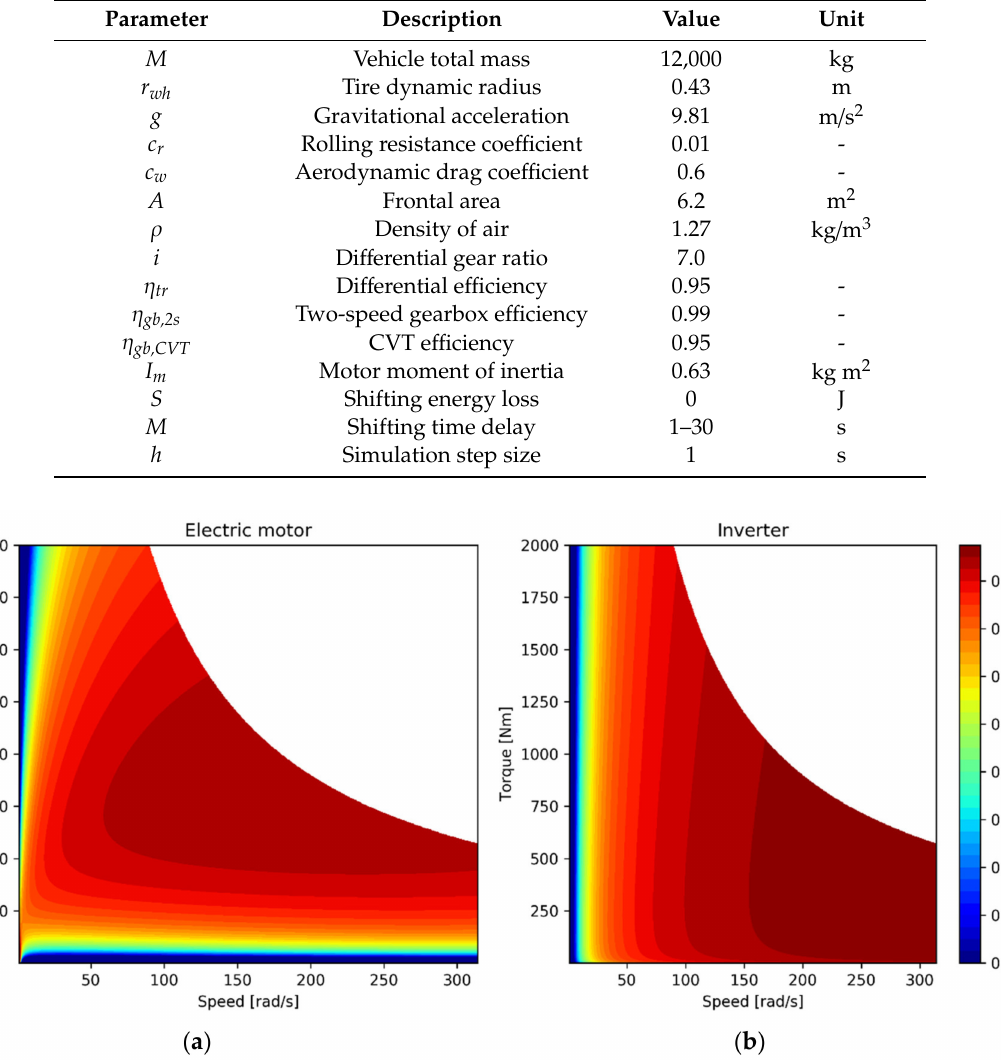
Figure 4. ( a ) Motor e ffi ciency map; ( b ) Inverter e ffi ciency